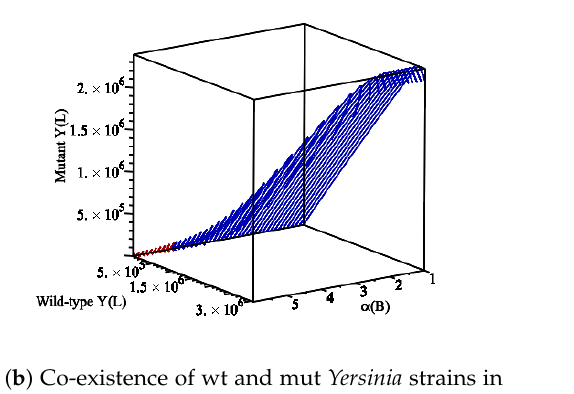
Figure 6. The diagram displays the appearance of the co-existence of wt and mut Yersinia strains as > 1 and R mut > 1. ( a ) An immune reaction influences the wt α ( B ) is changing in a region where R wt 0 0 and mut Yersinia strains in the mucosa. Additionally, another part is spilled over and moves to the lumen compartment. Therefore, they simultaneously increase or decrease to reach their maximum values. ( b ) The wt and mut Yersinia strains in the lumen simultaneously increase to reach the carrying capacity of the lumen compartment. In both ( a , b ), when α ( B ) reaches 4.90, the co-existence of wt and mut Yersinia strains